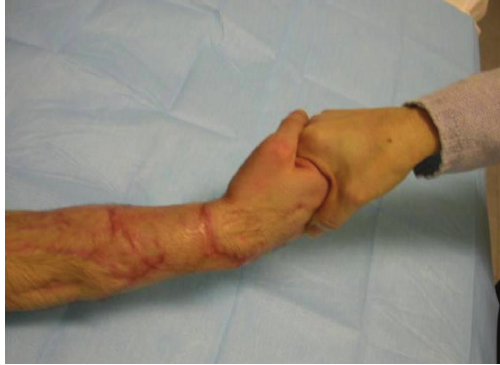
Figure 9: Followup at 1 year with 40% recovery of the extensor tendons.